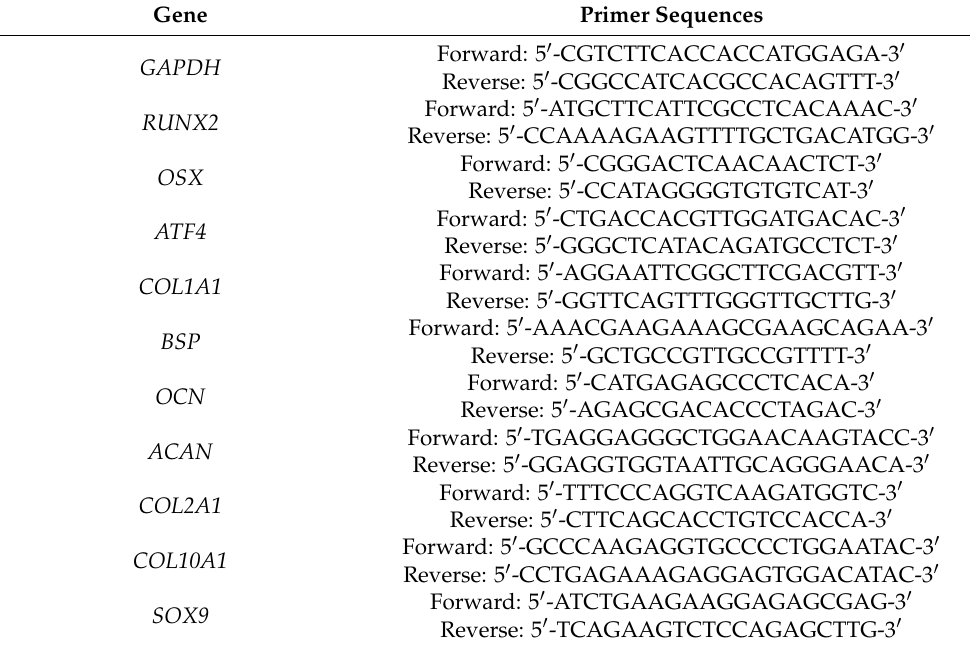
Table 2. Gene-specific primer sequences for real-time reverse transcription-polymerase chain reaction